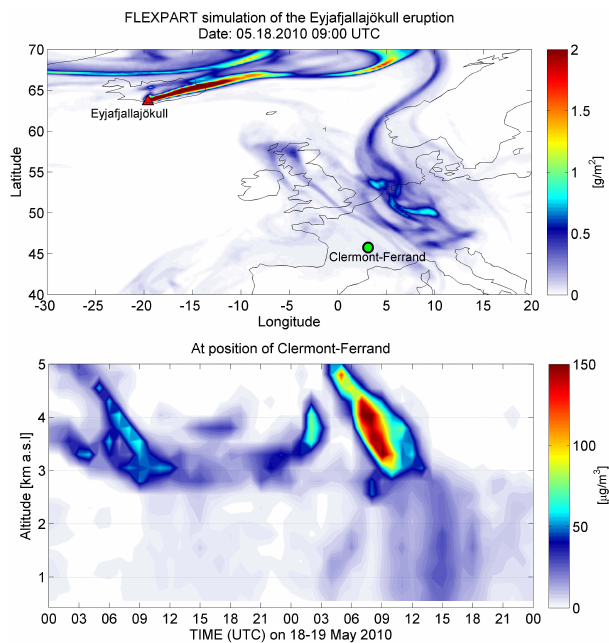
Fig. 1. FLEXPART simulated ash cloud. Total ash column load on 18 May 09:00UTC (upper panel), and simulated vertical distribu- tion of ash over Clermont-Ferrand for 18 and 19 May (lower